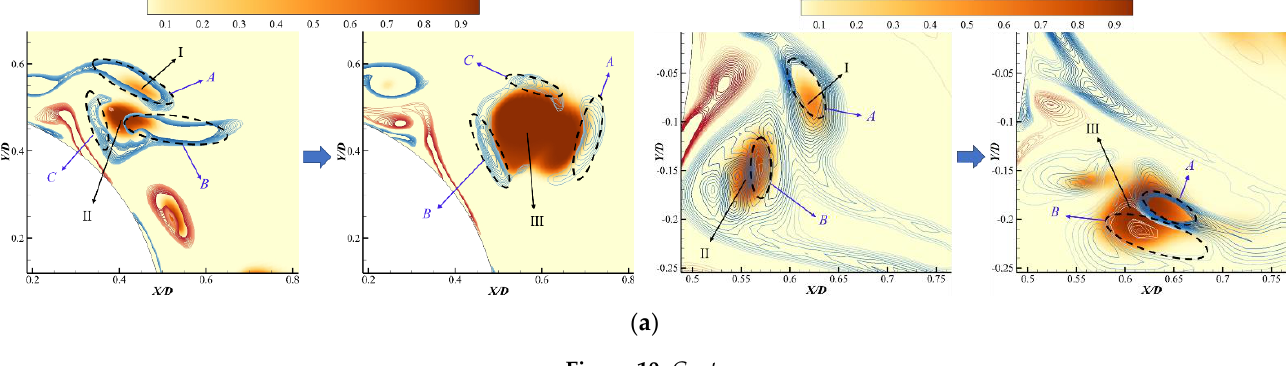
( b ) Figure 10. Interactions of vortical evolution and cavitation: ( a ) Merging; ( b ) Splitting. 5. Conclusions In this paper, characteristics of the cavitation in the cylinder wake containing mul- tiscale vortices are numerically investigated via LES coupled with the SS cavitation model. The following conclusions are drawn according to the detailed analyses: (1) The vortex shedding in the cylinder wake is quasiperiodic with an approximate frequency of 0.2, and this frequency may take a little drop if cavitation occurs. The SS cavitation model is more sensitive to the vapor – liquid two-phase volume fraction than the ZGB cavitation model, according to the theoretical analysis. (2) The cavitation could inhibit the shedding of the multiscale vortices because the cavitation could compress the upstream flow and thicken the boundary layer in the near wake region. With the decrease in the cavitation number, the cavitation area increases and further inhibits the vortex shedding. This phenomenon could make more vortices, as well as the attached cavities, appear on the cylinder surface.